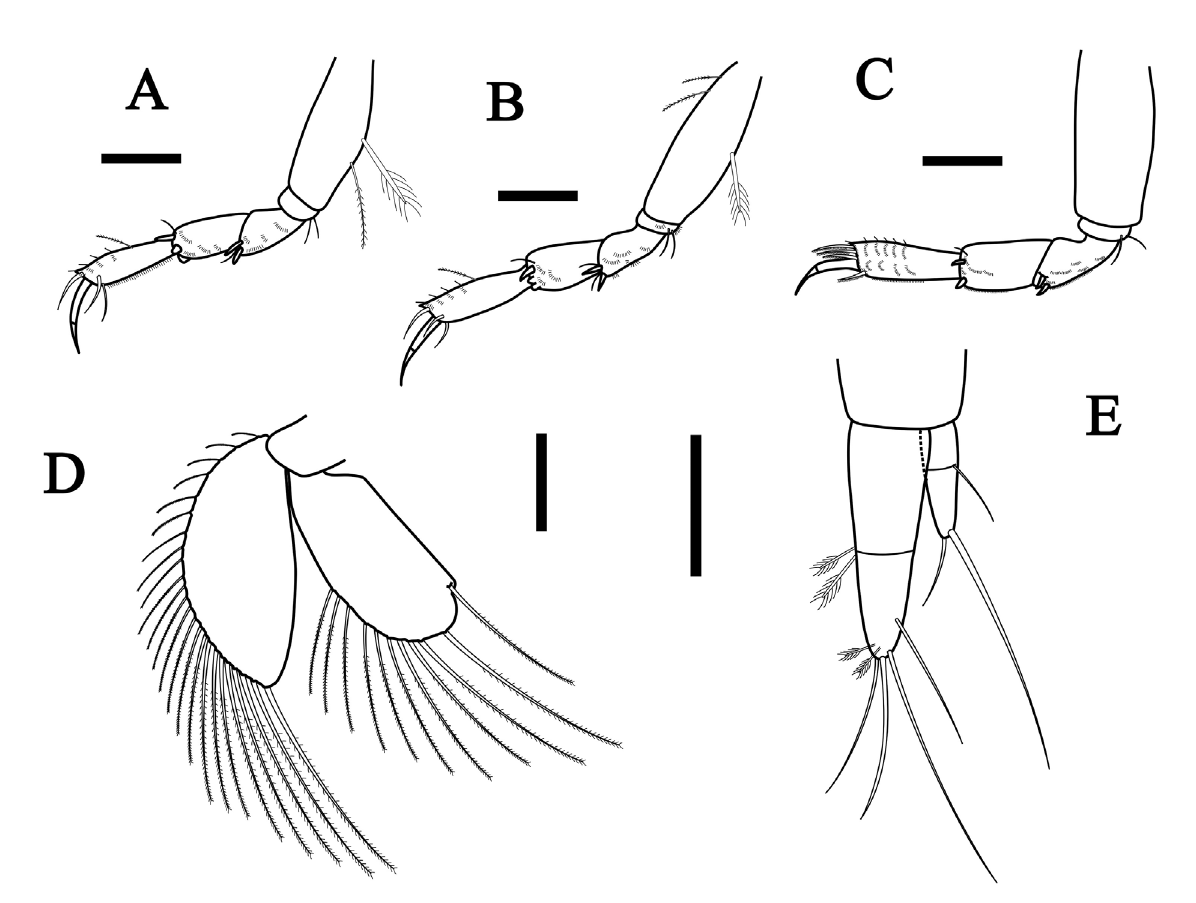
Figure 5. Tanaopsis brevicorpus sp. nov., female paratype, length 2.8, mm, MNRJ 23401. A, pereopod 4; B, pereopod 5; C, pereopod 6; D, pleopod; E, uropod. Scale bars = 0.1